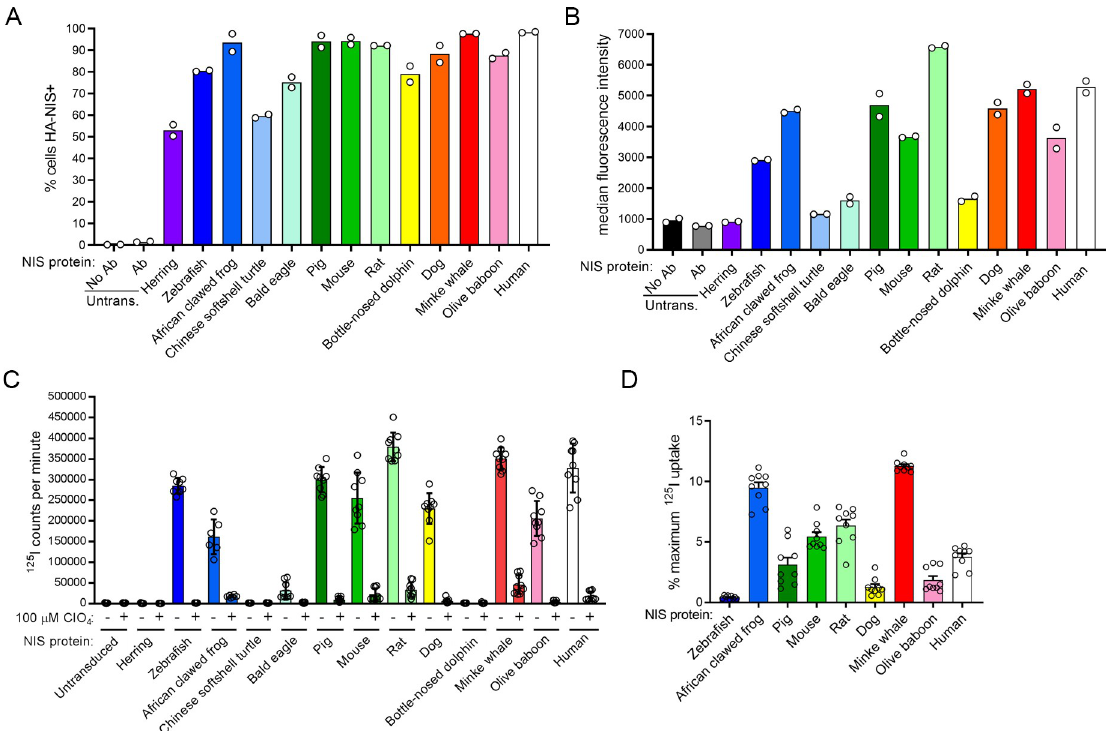
Fig 2. Characterization of HA-NIS protein expression and iodide transport. Species are ordered in ascending evolutionary proximity to humans as determined by TimeTree (pig, mouse, rat, and dog diverged equidistantly) [73]. (A) Percentage of 1.25 μ g/ml puromycin- selected cells which were positively-stained with α -HA-AlexaFluor647 antibody. (B) Median fluorescence intensity of 1.25 μ g/ml puromycin-selected cells which were stained with α -HA-AlexaFluor647 antibody. Values are averages of duplicate assays. (C) Absolute uptake value of each NIS protein in the absence or presence of 100 μ M perchlorate (ClO 4 ), which has not been equalized to protein expression. Values are averages of triplicate assays with standard deviation. (D) Percentage of maximum 125 I - uptake maintained in the presence of 100 μ M perchlorate. Untrans. = untransduced, Ab =